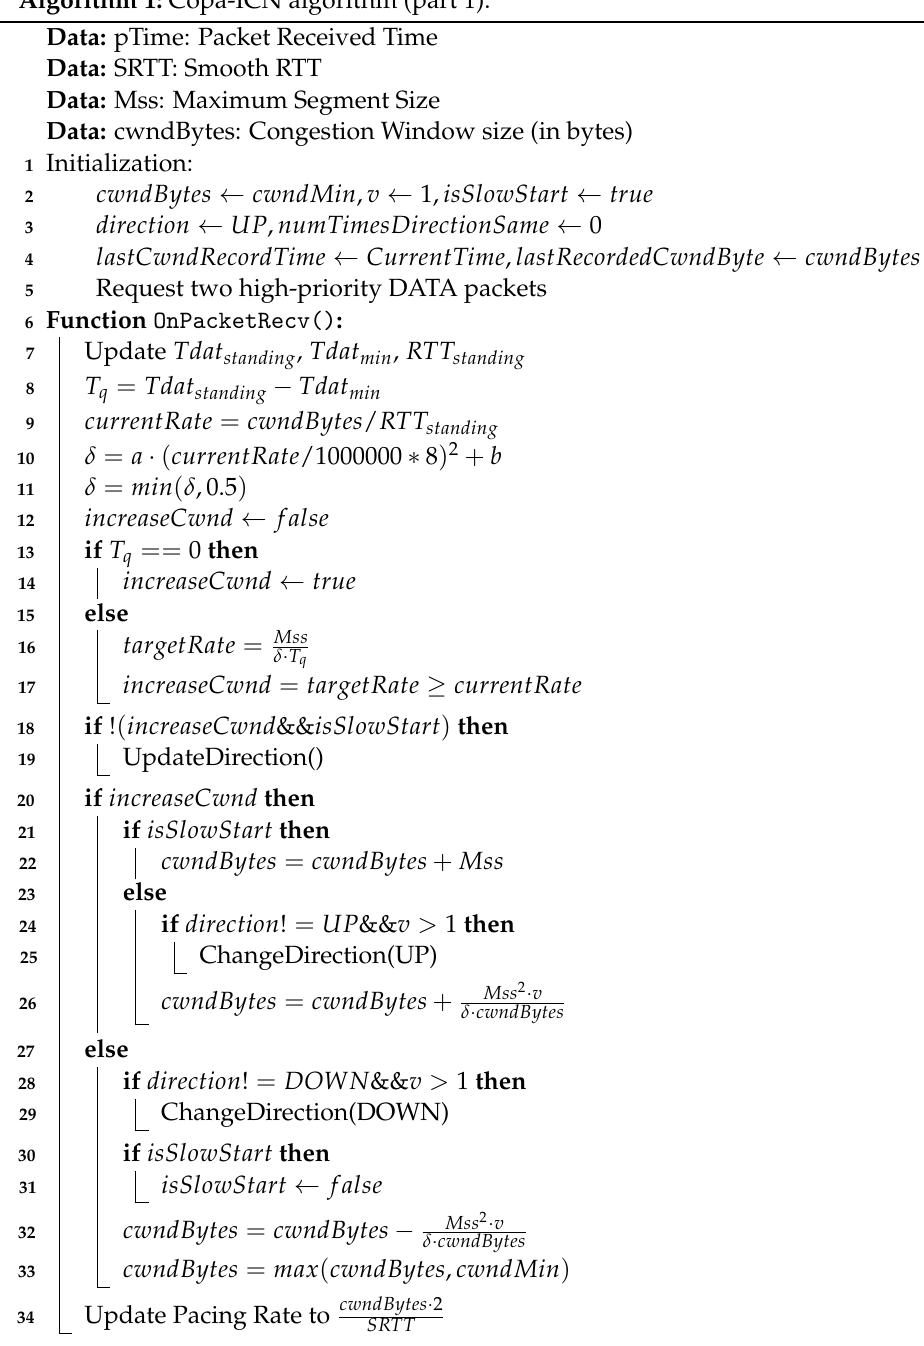
Algorithm 1: Copa-ICN algorithm (part